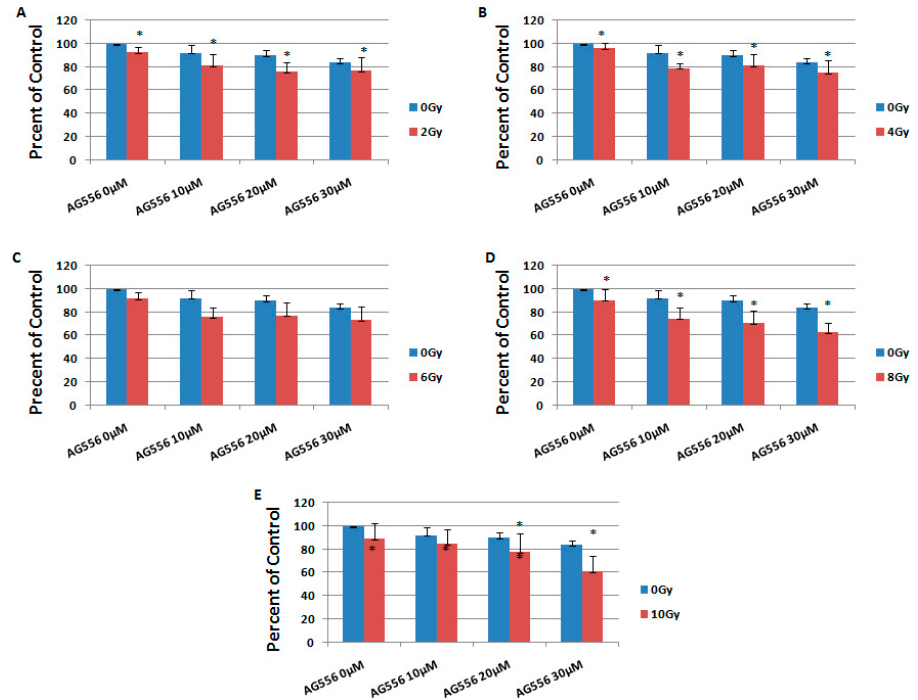
Figure 5. The effect of EGFR inhibition on ionizing radiation response in 11 HGG cells, three days after the treatment. The cells were seeded in 96-well culture plates (3000 cells/well) then irradiated with 2 Gy ( A ); 4 Gy ( B ); 6 Gy ( C ); 8 Gy ( D ); 10 Gy ( E ) and treated with 10 μ M, 20 μ M or 30 μ M